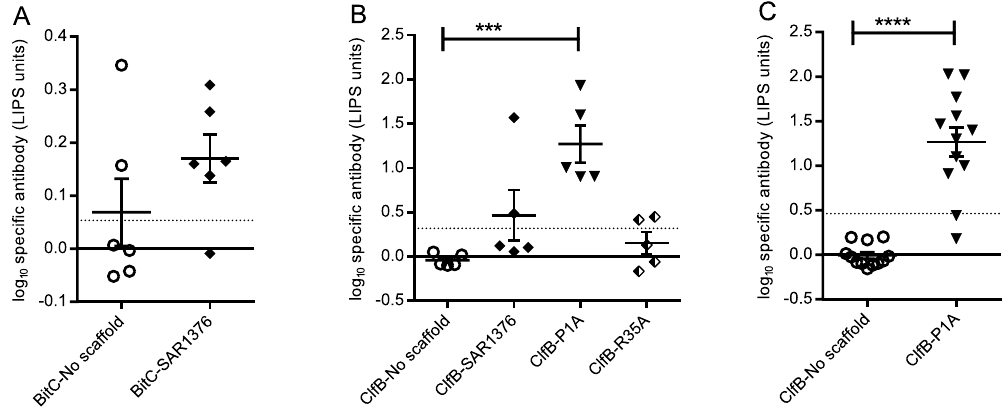
Figure 6. SAR1376 specific antibodies measured after vaccination with DNA vectors encoding the ClfB antigen with our without scaffold fused to the C-terminus of the antigen. ( A ) Antibody response against SAR1376 in BALB/c mice immunised with BitC-SAR1376 fusion protein. ( B ) Anti-SAR1376 antibody levels after vaccination of BALB/c mice with ClfB fused to SAR1376, SAR1376-P1A or SAR1376-R35A. ( C ) Anti- SAR1376 antibodies in CD1 mice immunised with ClfB-SAR1376 mutant P1A scaffold, as measured by LIPS assay. Each symbol represents a single mouse. Dotted line: three s.d. above assay background. *** p < 0.001; **** p < 0.0001.